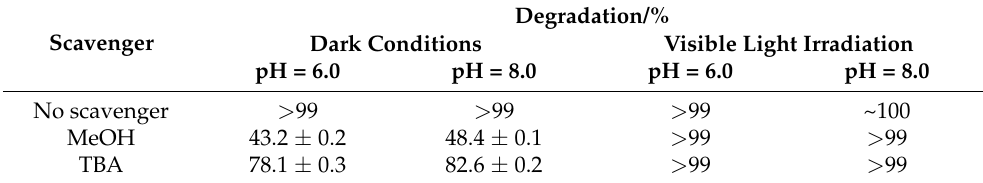
Table 6. Degradation of TC in dark conditions and under visible light irradiation (i.e., 5 mW cm − 2 ) in the presence and absence of